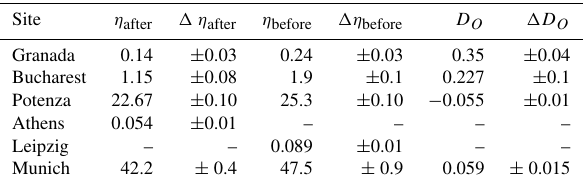
Table 2. Calibration values for EARLINET lidar systems perform- ing depolarization calibration